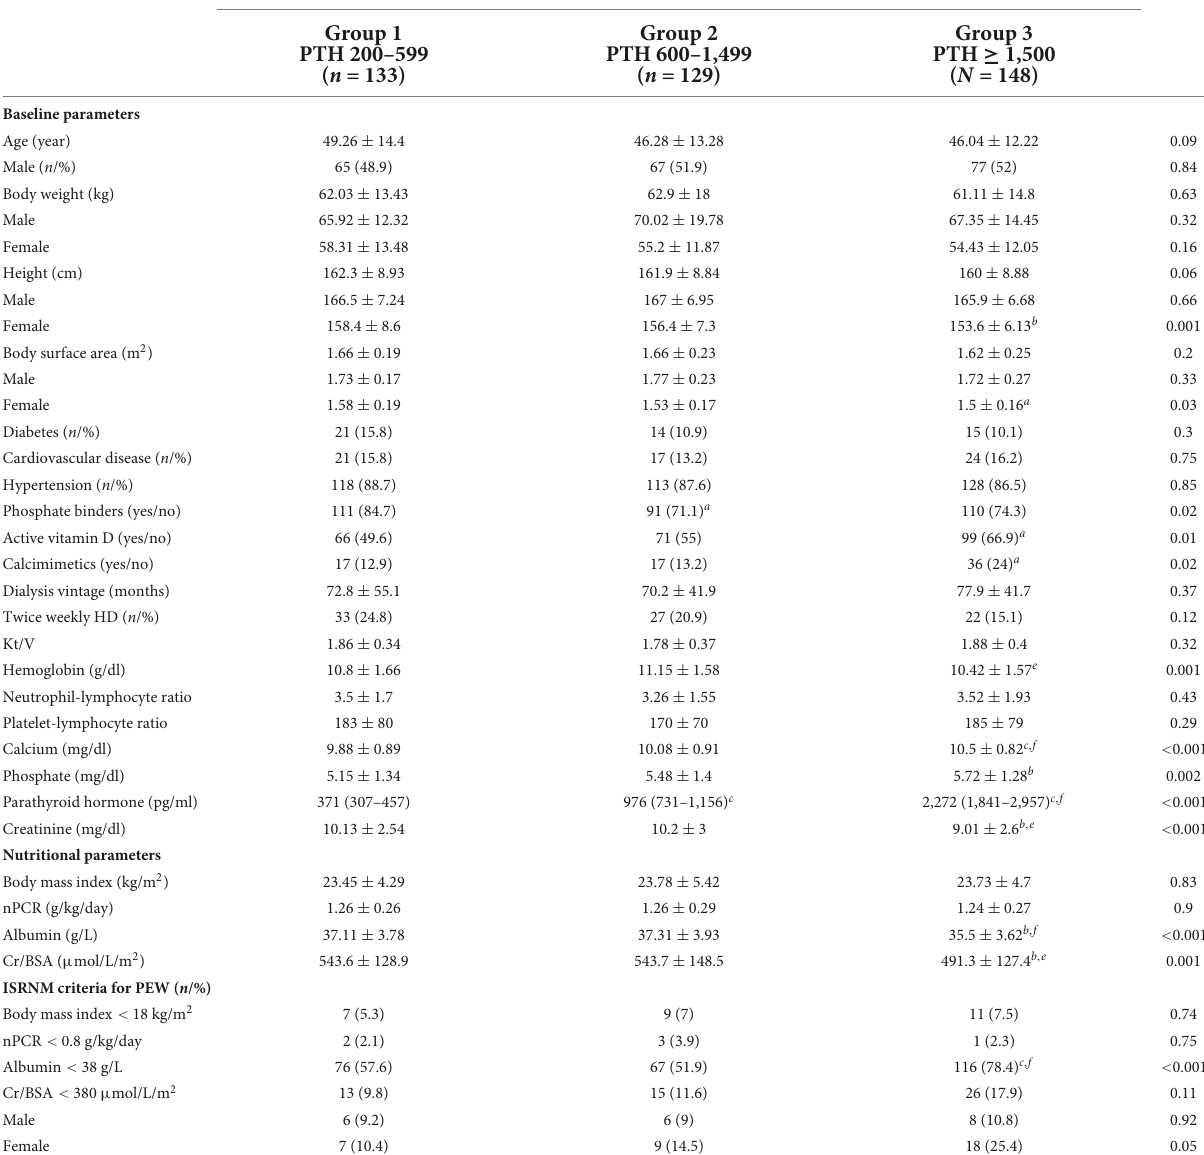
TABLE 1 Baseline biochemical and nutritional parameters according to parathyroid hormone